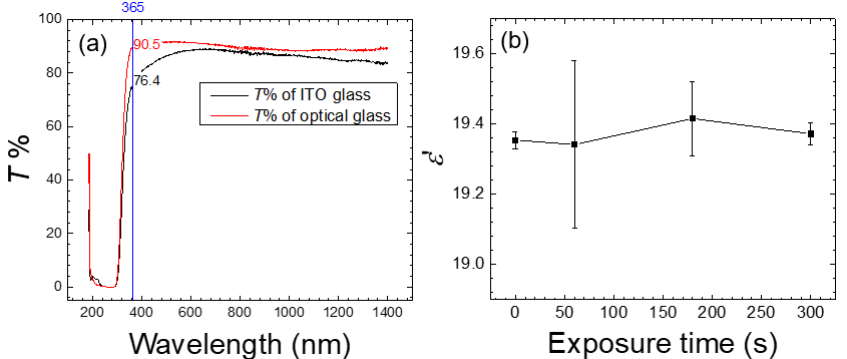
Figure 6. Transmission spectrometric analysis of glass substrates and dielectric measurement of E7 doped with 4-wt.% NOA65 in the absence of BSA. ( a ) Comparison of the optical transmission spectra of the optical and ITO-coated glass slides measured within a wavelength range of 200–1500 nm. ( b ) The real-part dielectric constant ε ’ determined at a UV irradiance of 20 mW/cm 2 with various exposure times. Error bars represent the standard deviation calculated from ε ’ of at least three independent experiments.